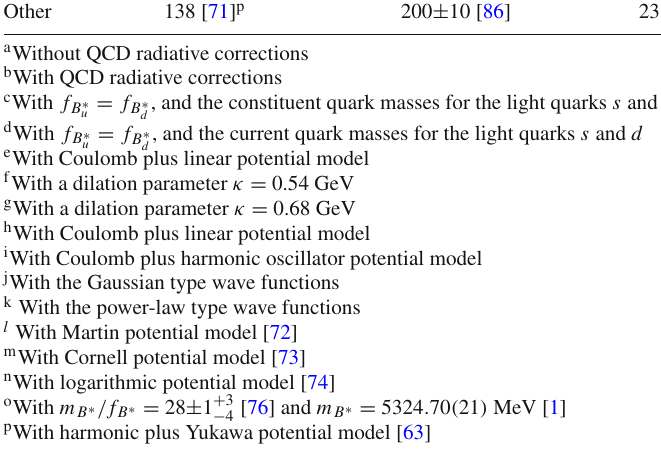
Table 5 The theoretical values of decay constant f B ∗ NRQM